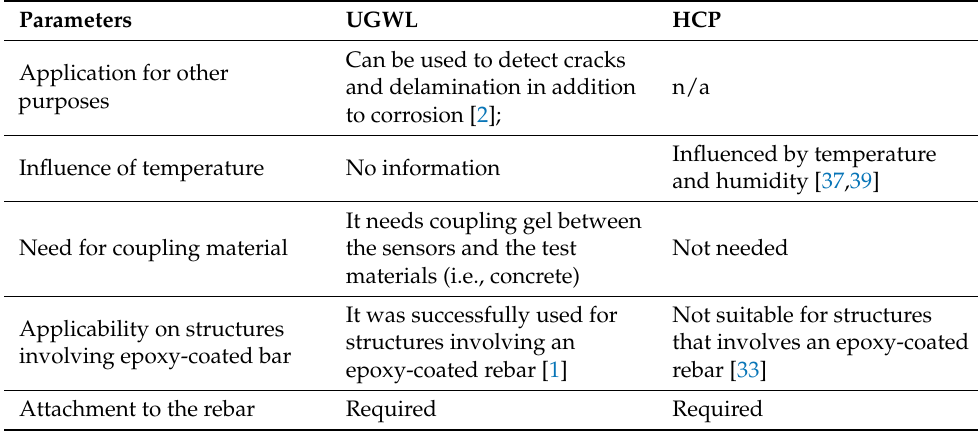
Table 4. Comparison between UGWL and HCP Methods.